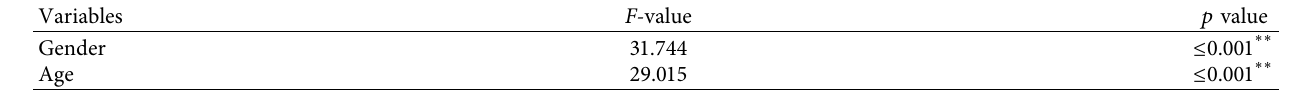
Table 16: Significance of gender and age on takeover